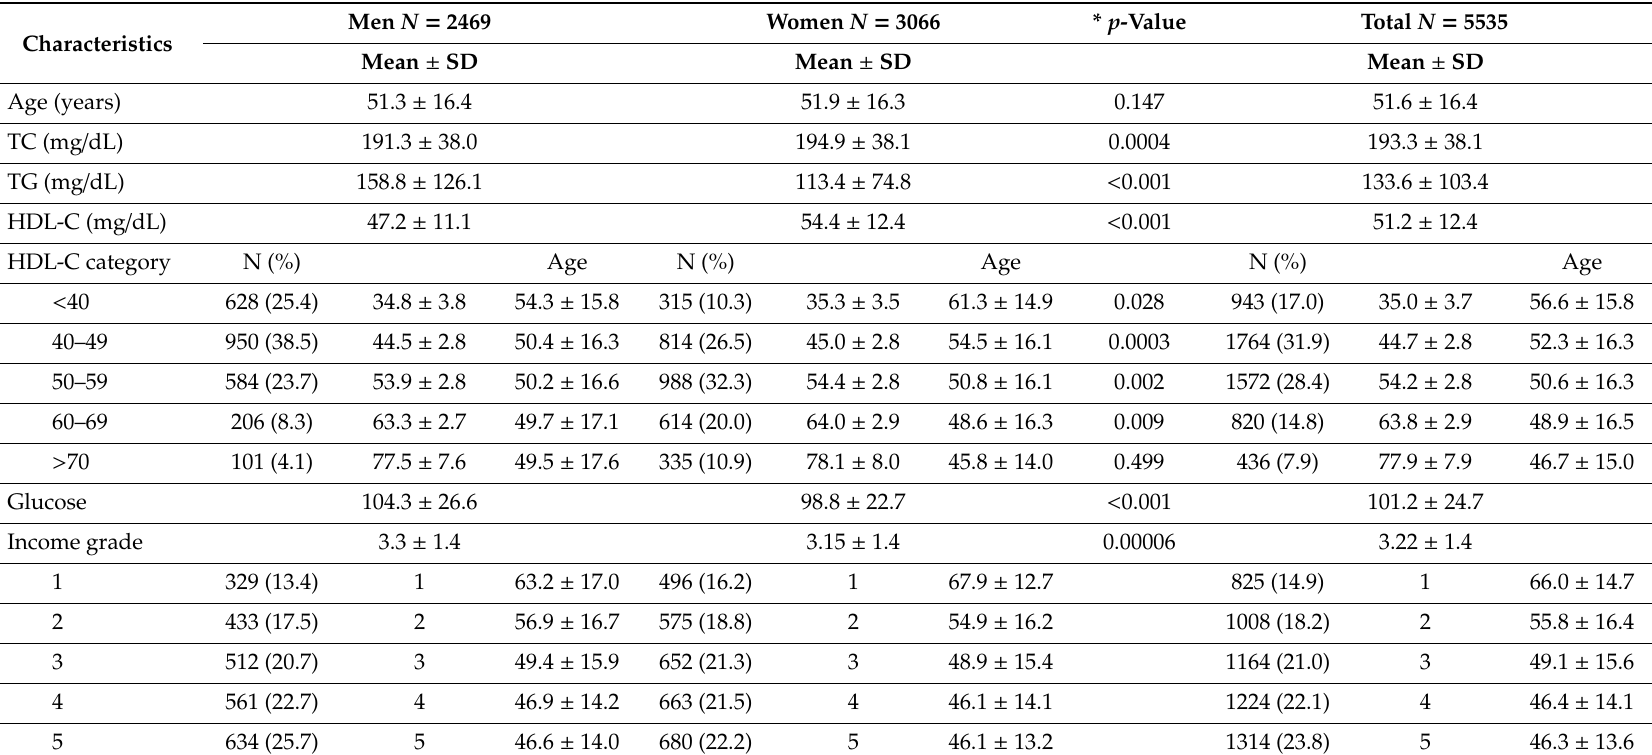
Table 1. General characteristics of study